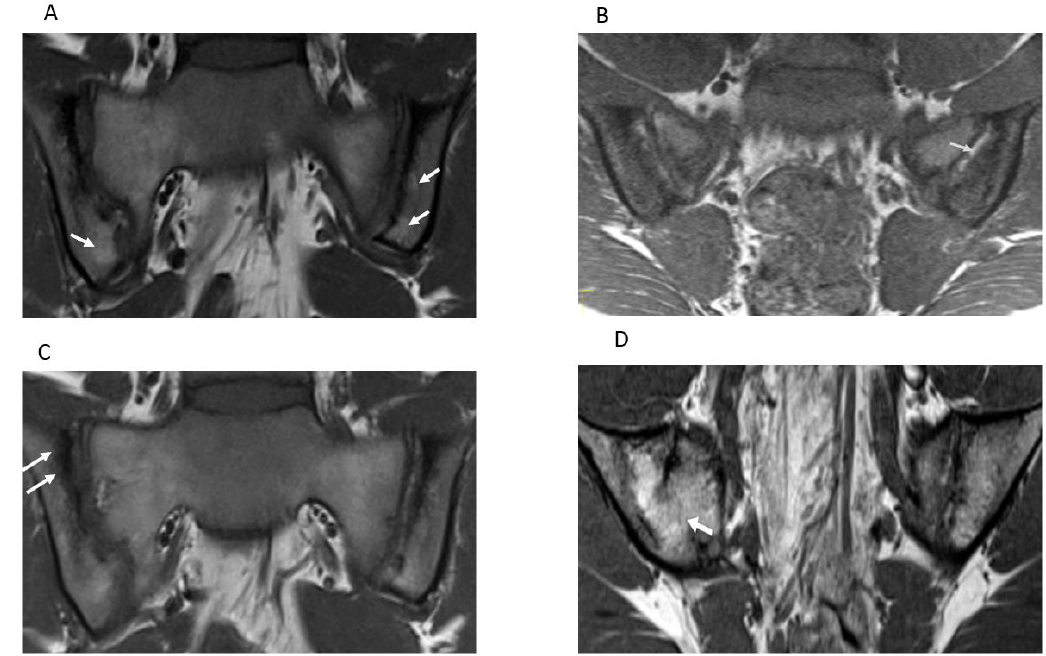
Figure 3. Semicoronal T1-weighted MR images ( A – D ) through the sacroiliac joint (SIJ) illustrate measurement components the JAMRIS-SIJ. ( A ) SIJ in a 16-year-old girl with ERA/JSp. ( A ) shows fat lesions as a homogenous increased T1 signal intensity within the inferior iliac subchondral bone (arrows), which is the more prominent on the left. ( B ) SIJ in a 15-year-old boy with ERA/JSpA, shows an area of backfill in the mid to superior subchondral cortex of the left iliac bone. There is increased signal (arrow) that is clearly demarcated from the adjacent normal marrow by irregular dark signal. ( C ) SIJ in a 16-year-old boy with ERA/JSpA shows sclerosis as a low subarticular signal on the superior iliac subchondral bone (arrows). ( D ) SIJ in a 13-year-old boy shows the bone marrow signal extending across the right SIJ (arrow), consistent with ankylosis.